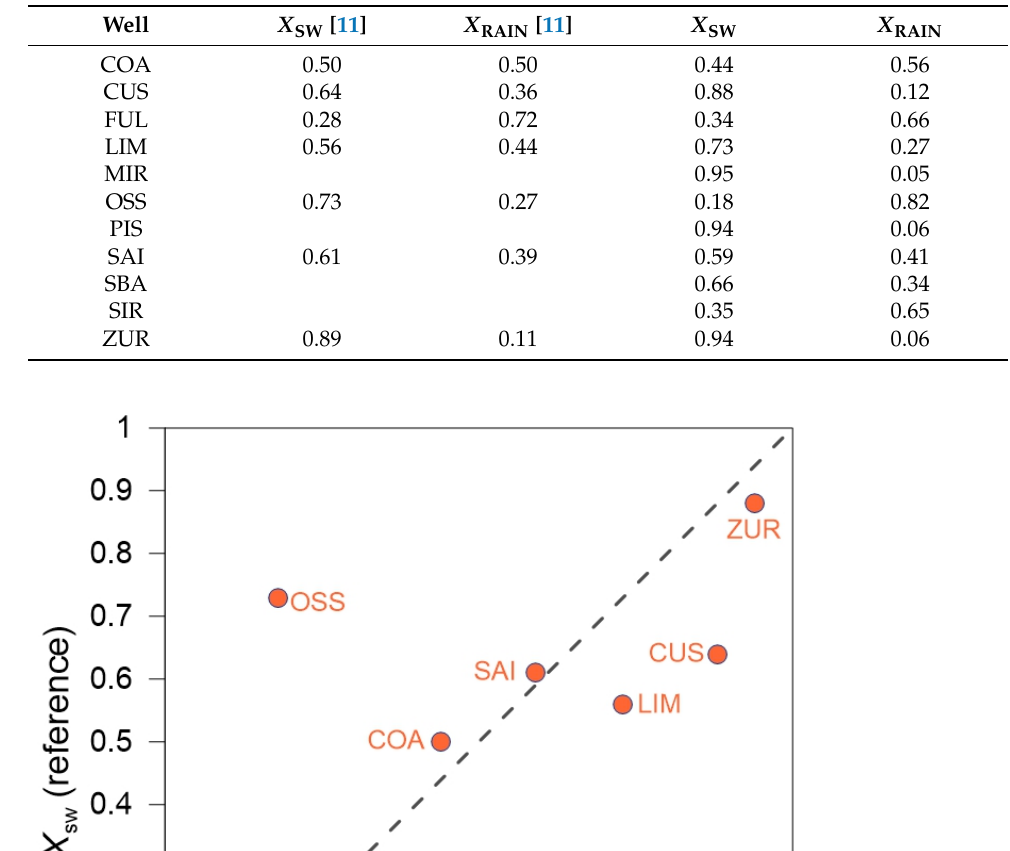
Table 3. Fractions of seawater ( X SW ) and rainwater ( X RAIN ) calculated using references [11,24] and new data of Cl concentrations.